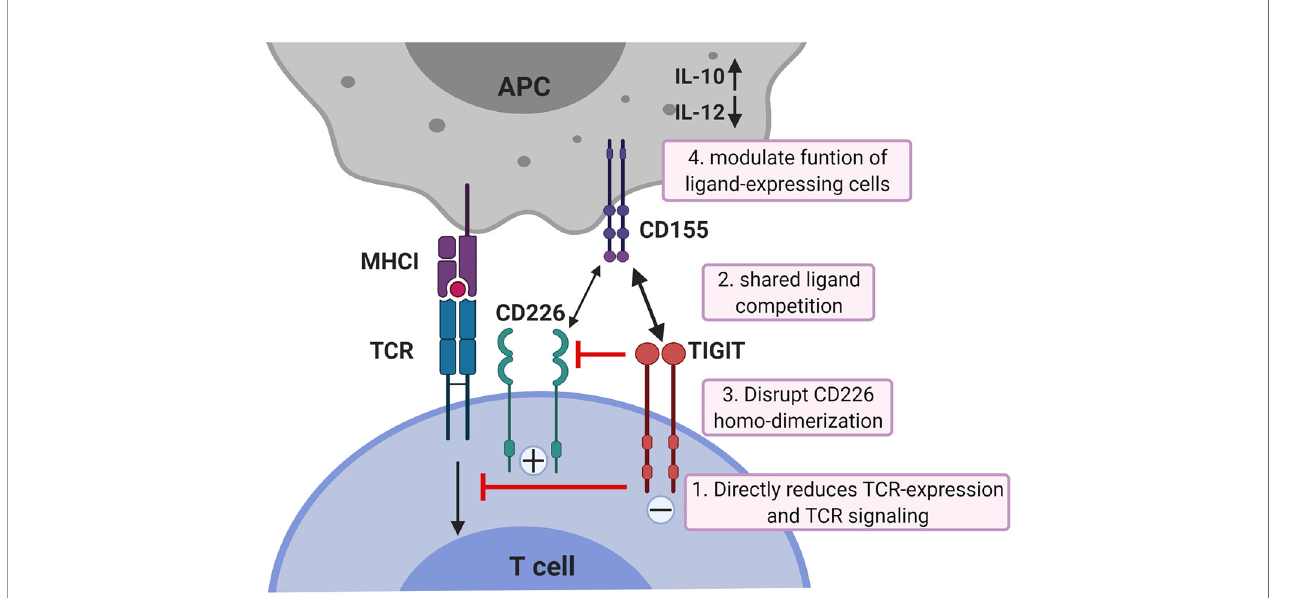
FIGURE 1 | Mechanisms of TIGIT inhibition in T cells. TIGIT displays multiple inhibitory mechanisms in T cells. 1) TIGIT binds to CD155 and delivers intracellular inhibitory signals which directly reduces TCR-expression and TCR signaling. 2) TIGIT binds to CD155 with much higher af fi nity than its co-stimulatory counterpart CD226 and thereby can replace CD226 from CD155 binding; 3) or disrupts CD226 homo-dimerization to inhibit CD226-mediated T cell activation. 4) TIGIT binds to CD155 on APCs to induce IL-10 production and decrease IL-12 production which indirectly inhibits T cells. APCs, antigen-presenting cells. The fi gure is adapted based upon the cartoon from Pauken KE et al.